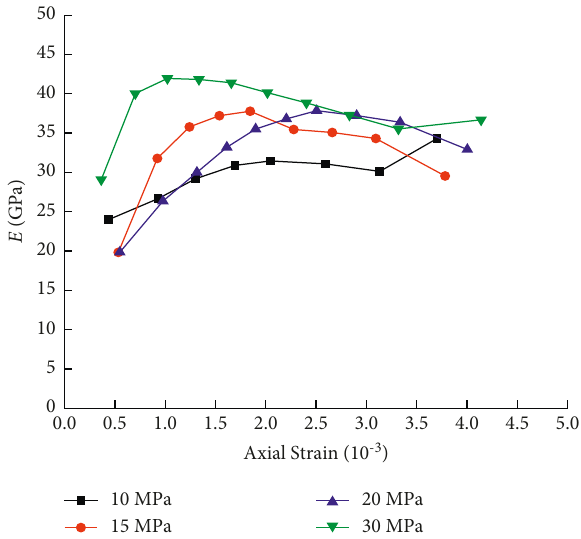
Figure 9: Elastic modulus—-strain curve during cyclic loading and